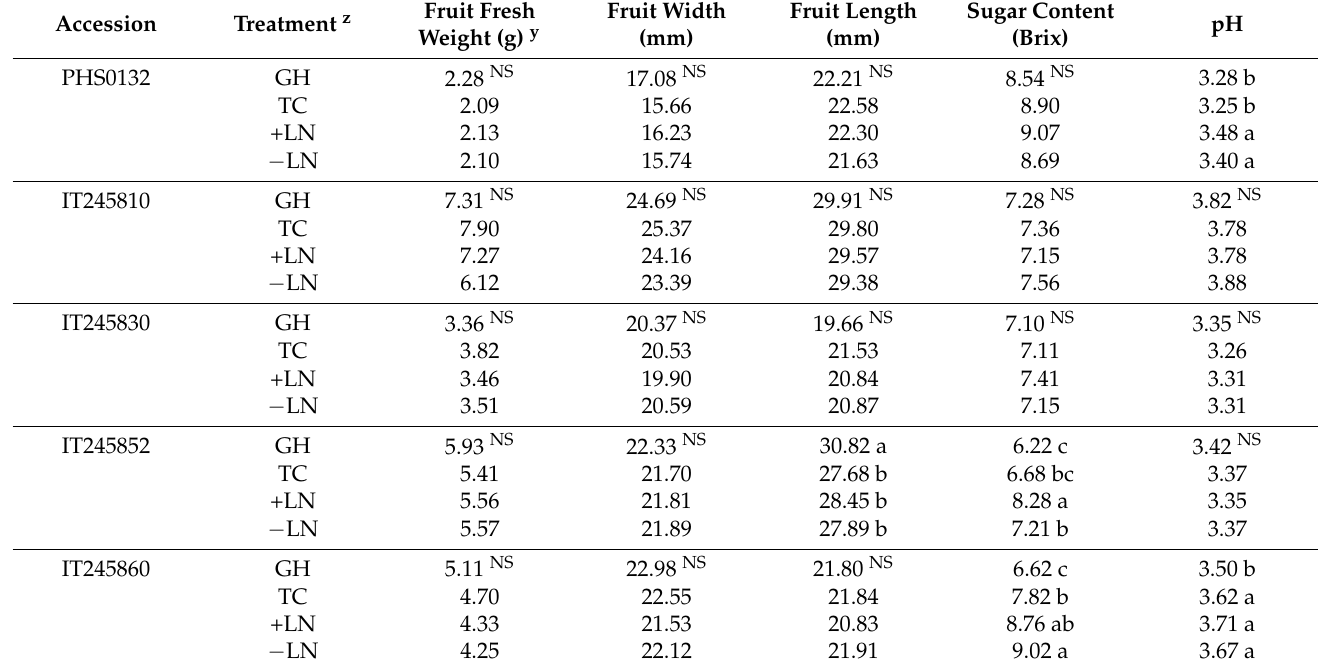
Table 4. Effects of four treatments on five fruit characters for five strawberry